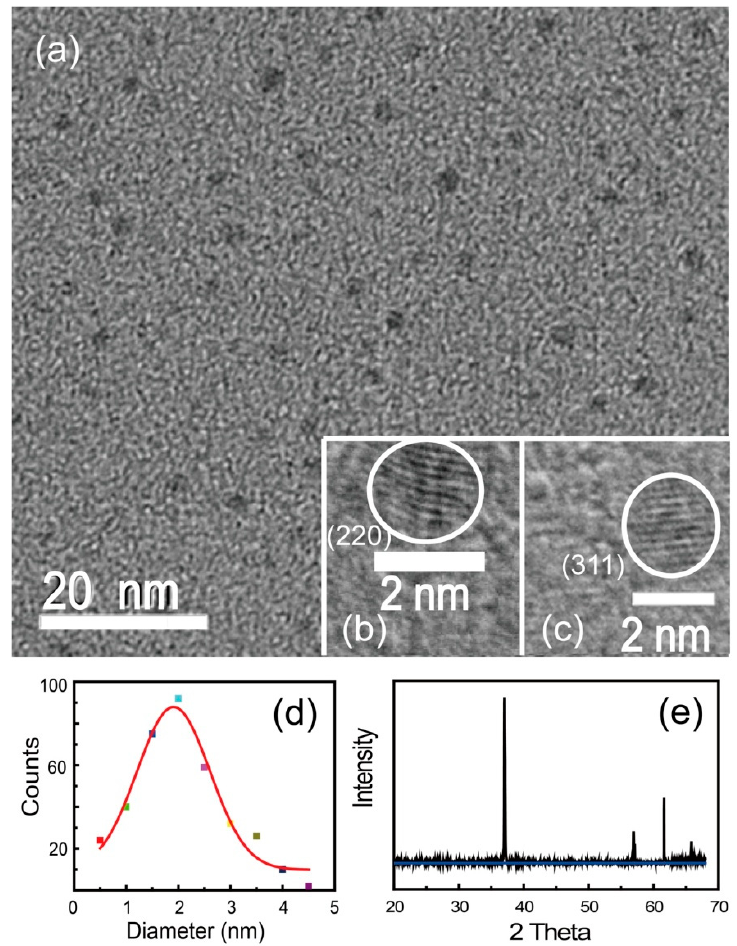
Figure 2. ( a ) A TEM image of silicon NCs; ( b , c ) HRTEM of silicon NCs, with lattice fringes corresponding to (220) and (311) planes of silicon; ( d ) size statistic of silicon NCs from a large number of TEM images. The most probable size of1.91 nm is calculated according to Gaussian fitting, as the curve shows; and ( e ) XRD line of silicon NCs.